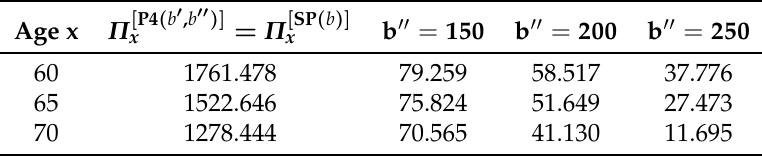
Table 8. Product P4 (enhanced pension); reduced benefit b (cid:48) , in order to obtain a given LTC benefit b (cid:48)(cid:48) ( b =